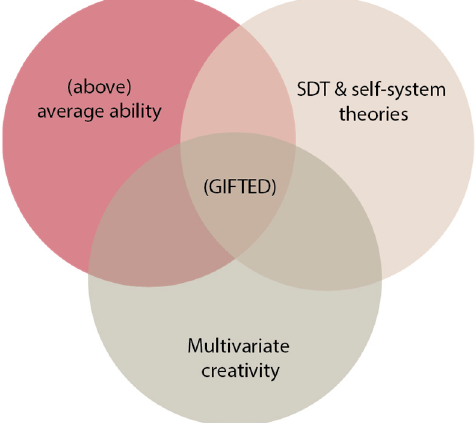
Figure 1. Graphical representation of intelligence in three rings, linked to theories of engagement and the multivariate approach to creativity. and the multivariate approach to